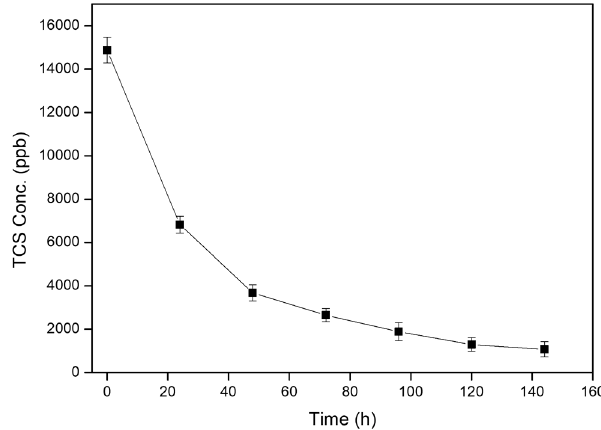
Figure 5. TCS removal in microbial fuel cells (MFC) during electricity generation.